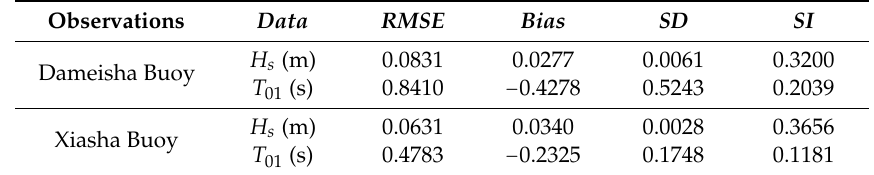
Table 9. Summary of the statistical errors for the simulations from 29 August to 5 September